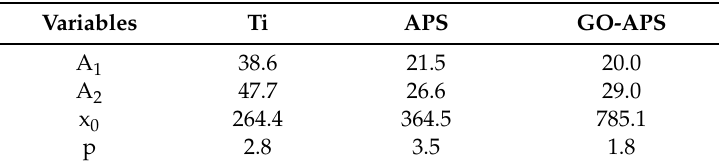
Table 1. Variables of Equation (4) for Figure 12.